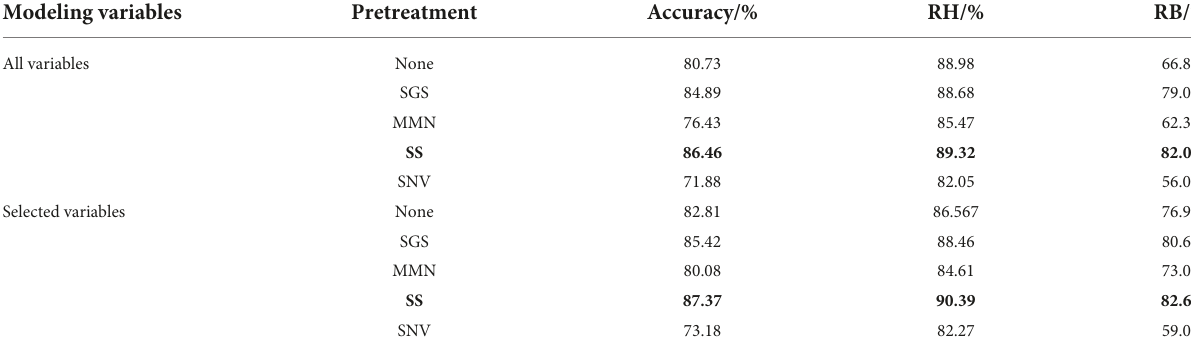
Modeling variables